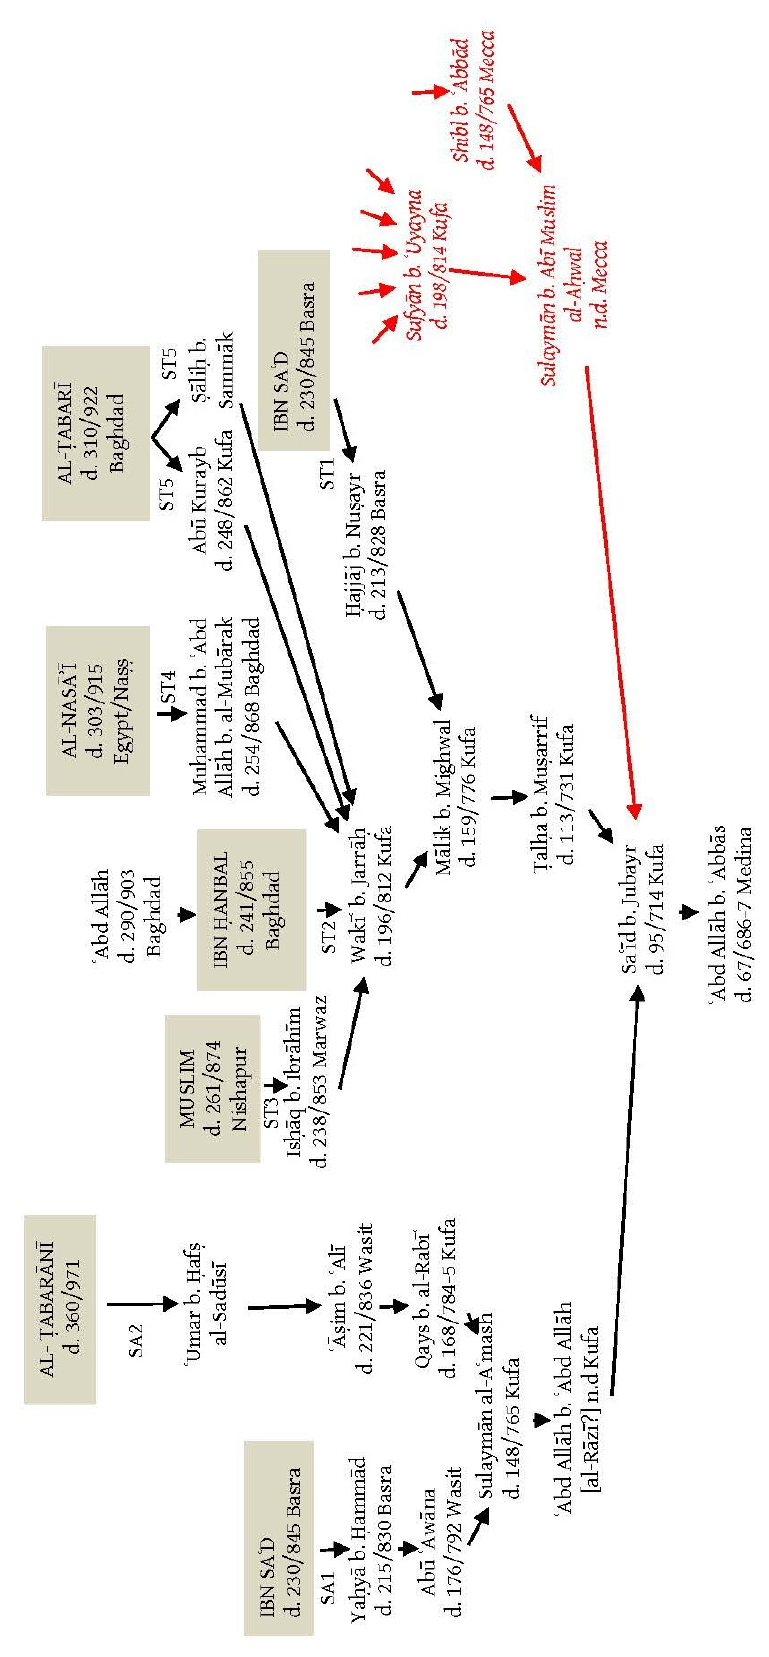
Figure A1. Isn¯ad Bundle of the Figure A1. Isn ā d Bundle of the Ibn ʿ Abb ā s Traditions from Sa ʿ ī d b. Jubayr.